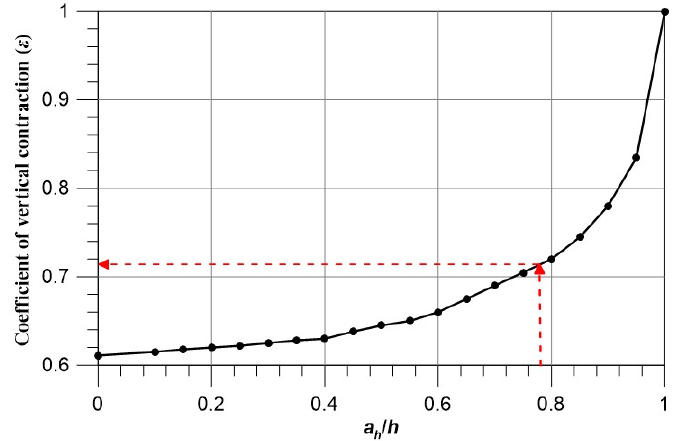
Figure 6. Estimation of the coefficient of vertical contraction ε as a function of the a h /h ratio [46].